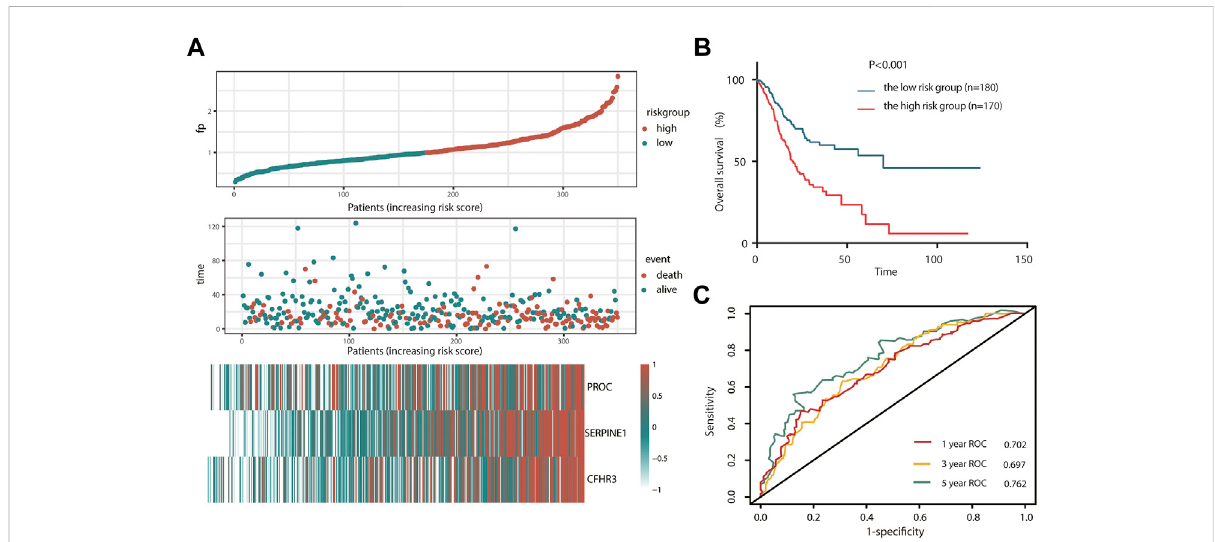
FIGURE 3 Prognosis analysis of complement system-related three-gene signature in TCGA cohort. (A) Detailed risk scores, survival status of TCGA STAD patients, and heatmap of three complement system-related genes in TCGA cohort. (B) K – M curves for the overall survival of patients in high- and low-risk groups. (C) ROC curves. K – M, Kaplan – Meier; ROC, receiver operating characteristic curve.